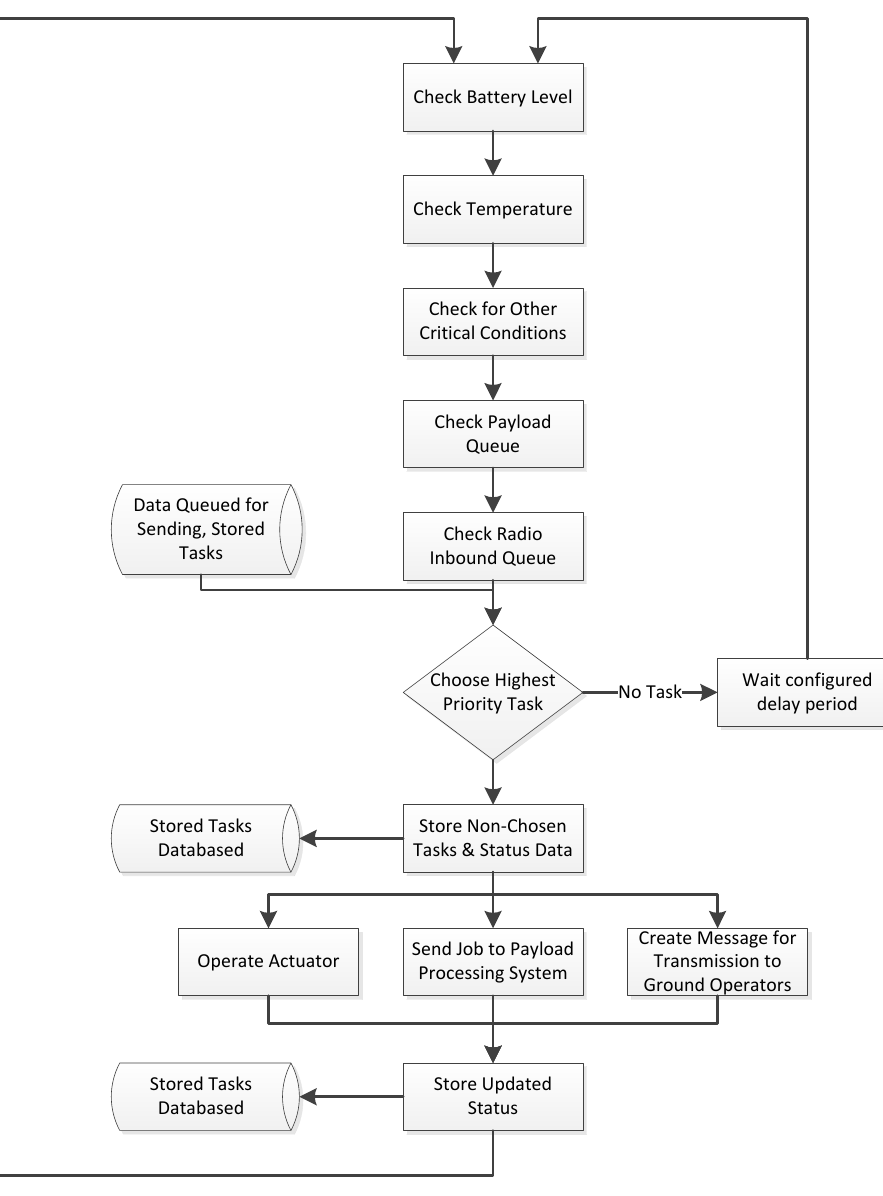
Figure 7. Operating Software